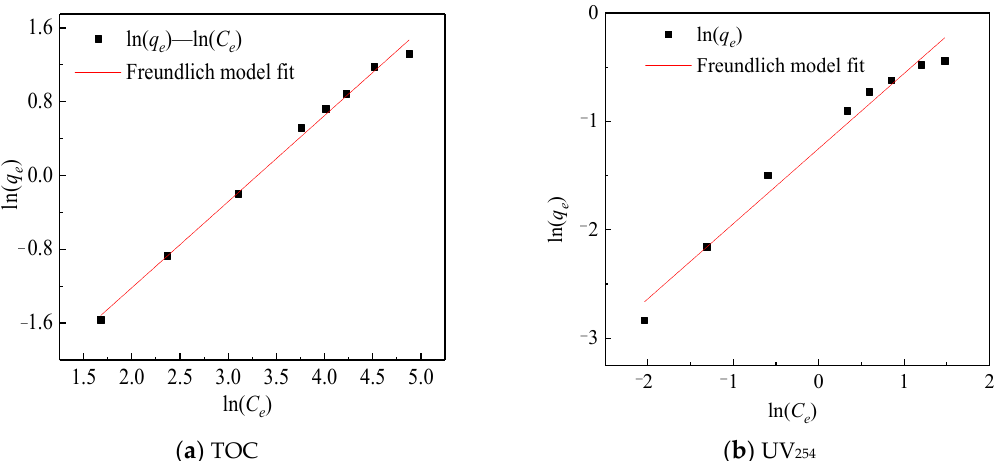
Figure 5. Freundlich model fitting map.